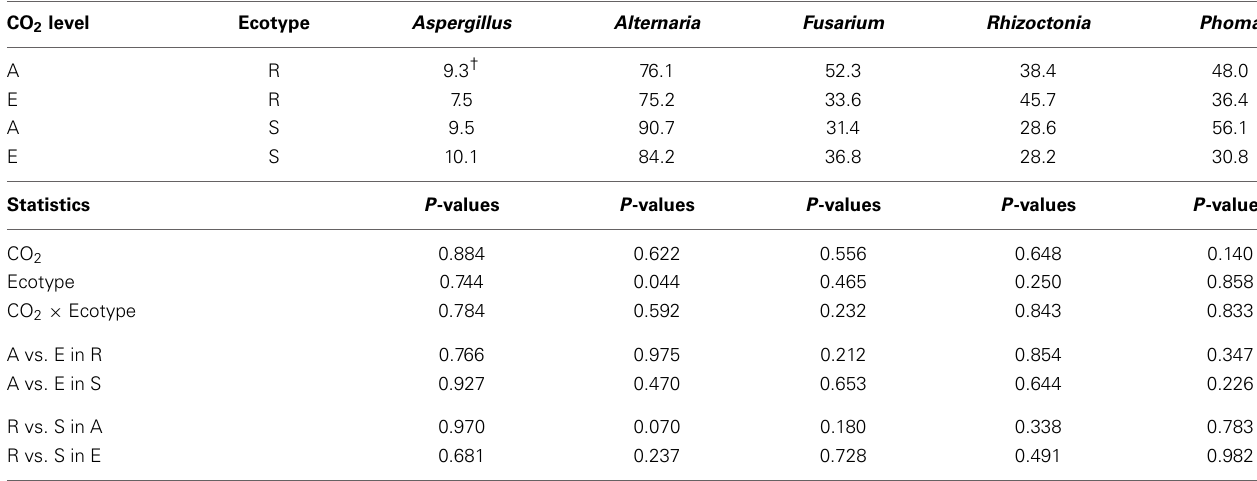
Table 3 | Effects of atmospheric CO 2 concentration (ambient, A = 375 µ mol mol − 1 ; elevated, E = ambient + 200 µ mol mol − 1 ) on frequency of fungi associated with two ecotypes (R = Resistant; S = Susceptible to Glyphosate) of common ragweed